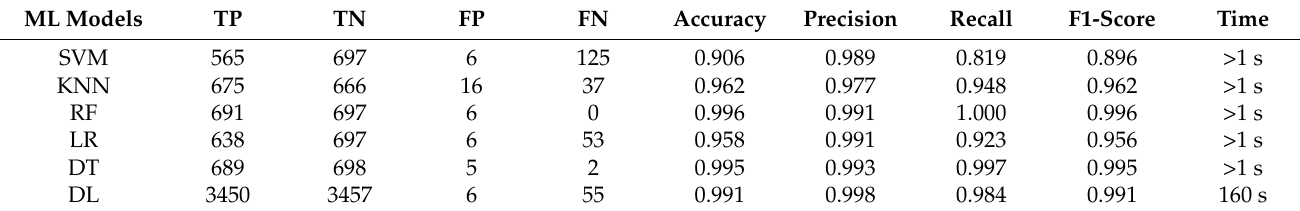
Table 4. Results of performance the different models for data 2009–2013 and 2018–2022.